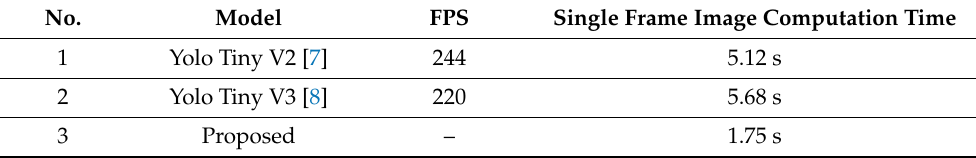
Table 5. Comparison of the real-time performance of